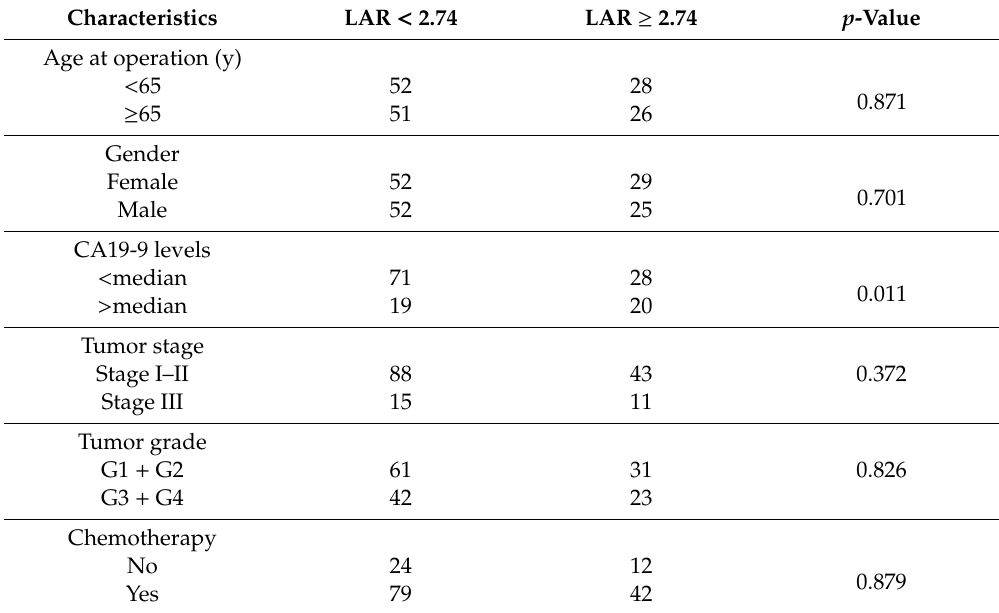
Table 1. The relationship between clinico-pathological parameters and the pretreatment lipase-to-amylase ratio (LAR) in patients with surgically resectable pancreatic adenocarcinoma ( n = 157). Characteristics